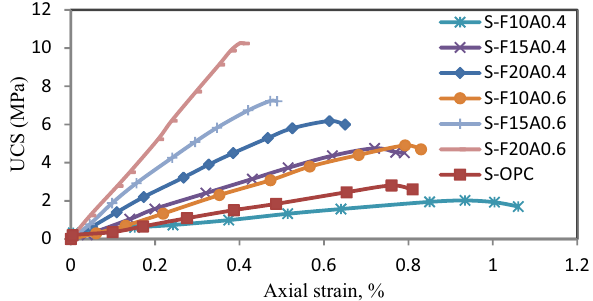
Figure 4: Crack development in a GP - soil beam under fl exural